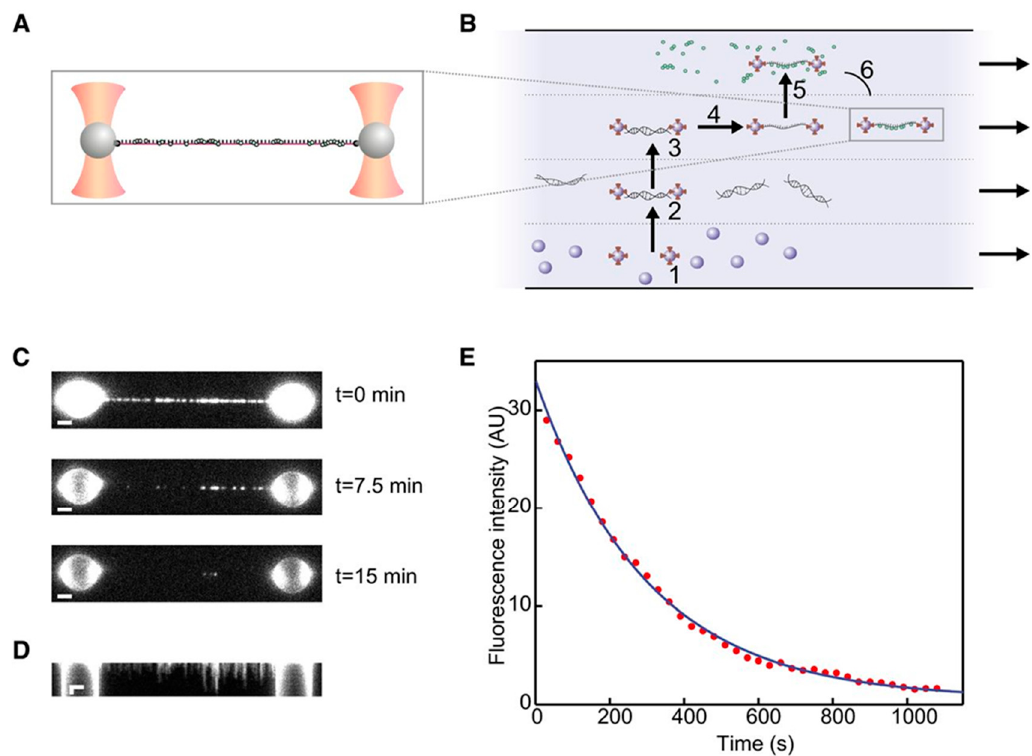
Figure 7. Experiment by Brouwer et al. [97]. ( A ) Dual-trap setup: the molecular construct under study comprises single-stranded DNA (ssDNA) to which fluorescently labeled RAD51 complexes (represented as green dots) are attached. ( B ) Four-channel microfluidic system used to assemble the molecule: the traps capture two polystyrene beads from the bottom channel (1), then a double-stranded DNA (dsDNA) segment is attached to the beads (2), isolated (3), and stretched to form ssDNA (4). RAD51 proteins interact with ssDNA in the top channel (5). Finally, the construct is moved to the free channel where measurements are performed (6). ( C ) From these images obtained by epi-illumination, the fluorescence intensity as a function of time is estimated. ( D ) Kymograph of the same dataset in (C). ( E ) An exponential fitted to the data yields an estimation of the disassembly rate. AU: Arbitrary units. Reprinted with permission from [97].